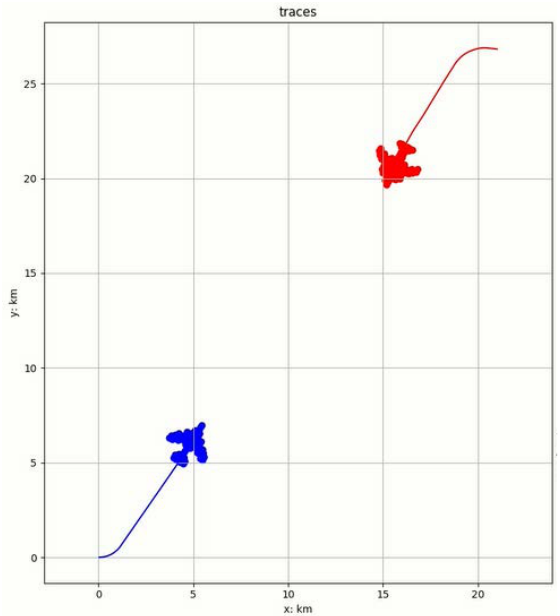
Figure 13. 2D disadvantage: air confrontation process.